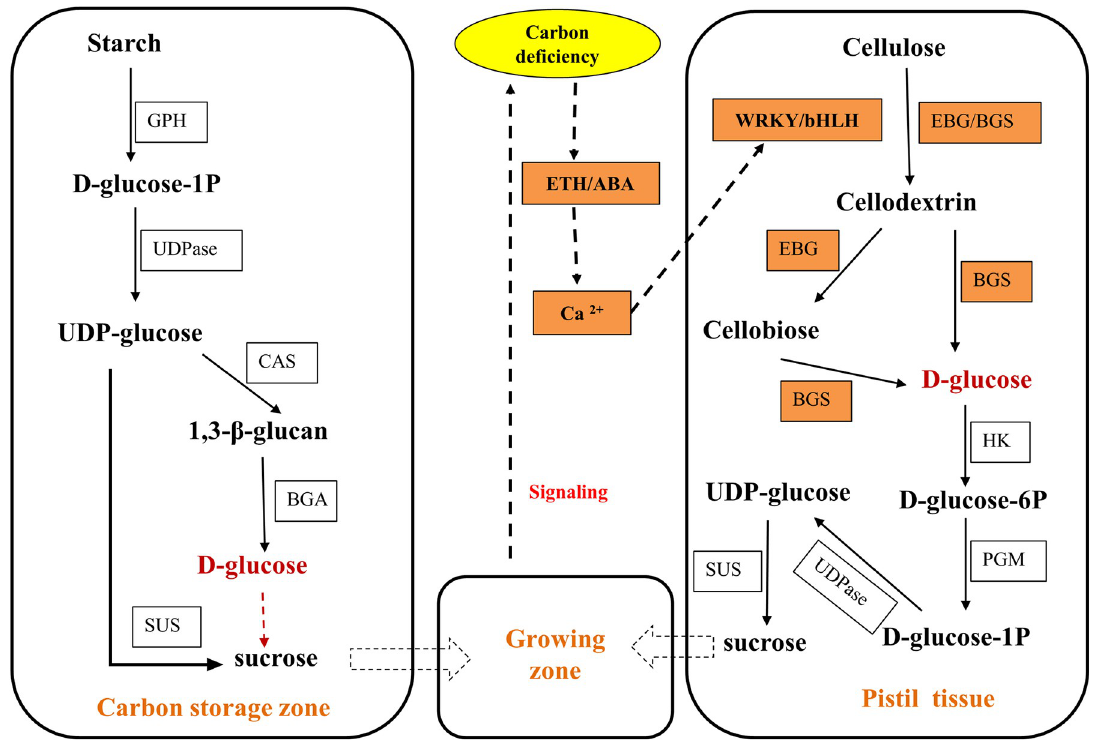
Fig 11. Schematic diagram of the mechanism of pistil abortion in